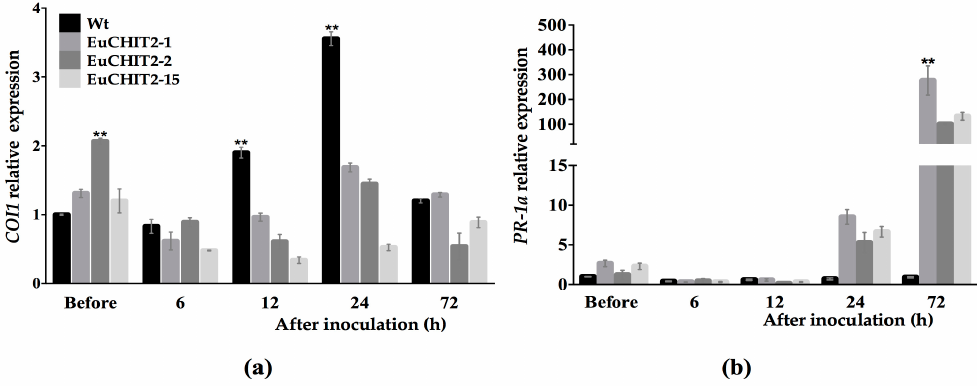
Figure 6. Relative expression levels of pathogen-related genes in Wt (wild-type) and transgenic tobacco leaves before and after of E. cichoracearum DC inoculation, ( n = 3). ( a ) COI1 relative expression levels; ( b ) PR-1a relative expression levels. EuCHIT2-1, EuCHIT2-2, and EuCHIT2-15 are three individual transgenic tobacco lines with EuCHIT2 overexpression. Error bars indicate standard deviation, and ** indicates significant differences at p < 0.01, respectively.